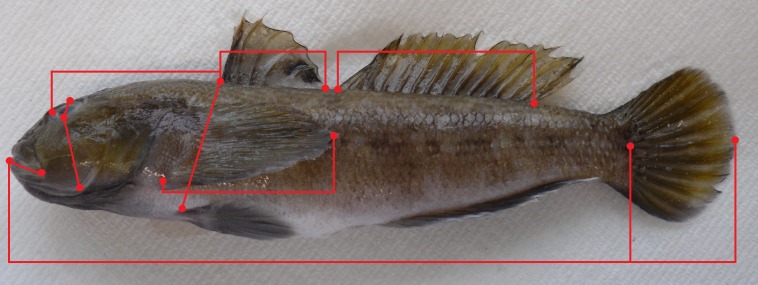
Schematic drawing of Round Goby, Neogobius melanostomus, with illustration of distance-based measurements (red dots) taken from the lateral view.The following morphometric characters were measured as follows: pre-orbital distance (PD, distance between the front of the upper lip to the orbit), eye diameter (ED, the greatest bony diameter of the orbit), lower jaw length (LJW, straight line measurement between the snout tip and posterior edge of mandible), cheek size (CS, males only: maximum depth measured from the lower edge of the orbit to the base of the gill slits), body depth (BD, maximum depth measured from the base of the 1st dorsal fin to the pelvic fin), pectoral fin length (PFL, from the base to the tip of the pectoral fin), pre-dorsal fin length (PDL, front of the upper lip to the base of the 1st dorsal fin), 1st dorsal fin length (DFL1, from the base of the 1st dorsal spine to the base of the last dorsal ray from the 1st dorsal fin), and 2nd dorsal fin length (DFL2, from the base of the 1st dorsal spine to the base of the last dorsal ray from the 2nd dorsal fin).